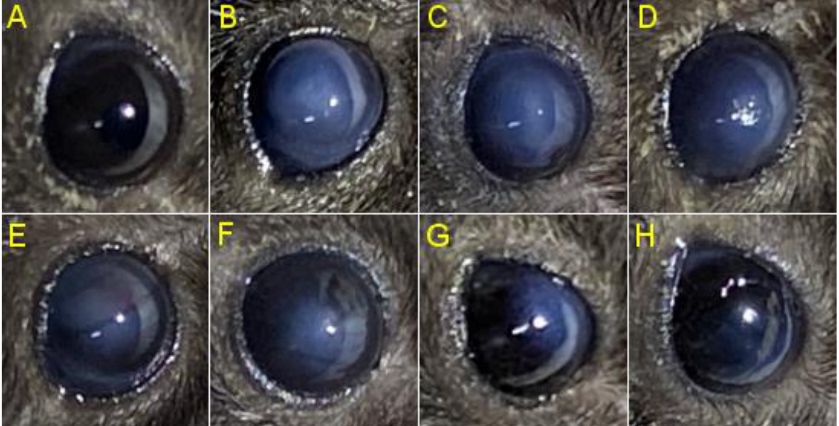
Figure 4. Comparison of corneal haze induced by alkali burn after 15 days of treatment. Representative photographs from the different experimental groups are presented and are as follow; ( A ) non-burned eye, ( B ) PBS treated eye, ( C ) empty liposome treated eye, ( D ) dexamethasone treated eye, ( E ) 0.02% PFD treated eye, ( F ) 0.1% PFD treated eye, ( G ) 0.02% PL treated eye and ( H ) 0.1% PL treated eye. PFD ( E , F ) and PL ( G , H ) treated eyes have a greater reduction in haze extension and density than those eyes treated with PBS ( B ), empty liposomes ( C ) and dexamethasone ( D ). PBS, phosphate buffered saline; PFD, pirfenidone; PL, pirfenidone-loaded liposome.